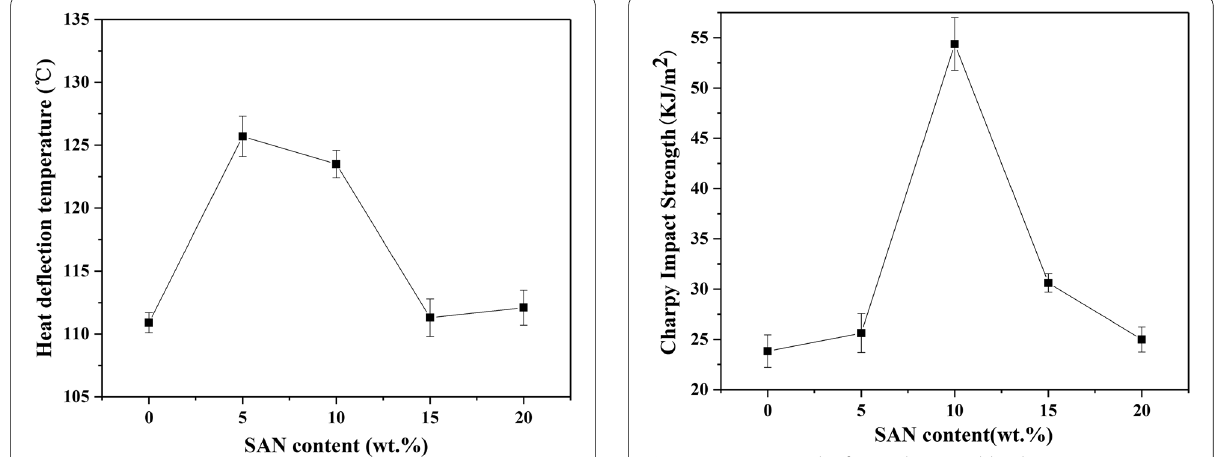
Fig. 6 HDT values of PP and SAN/PP blends